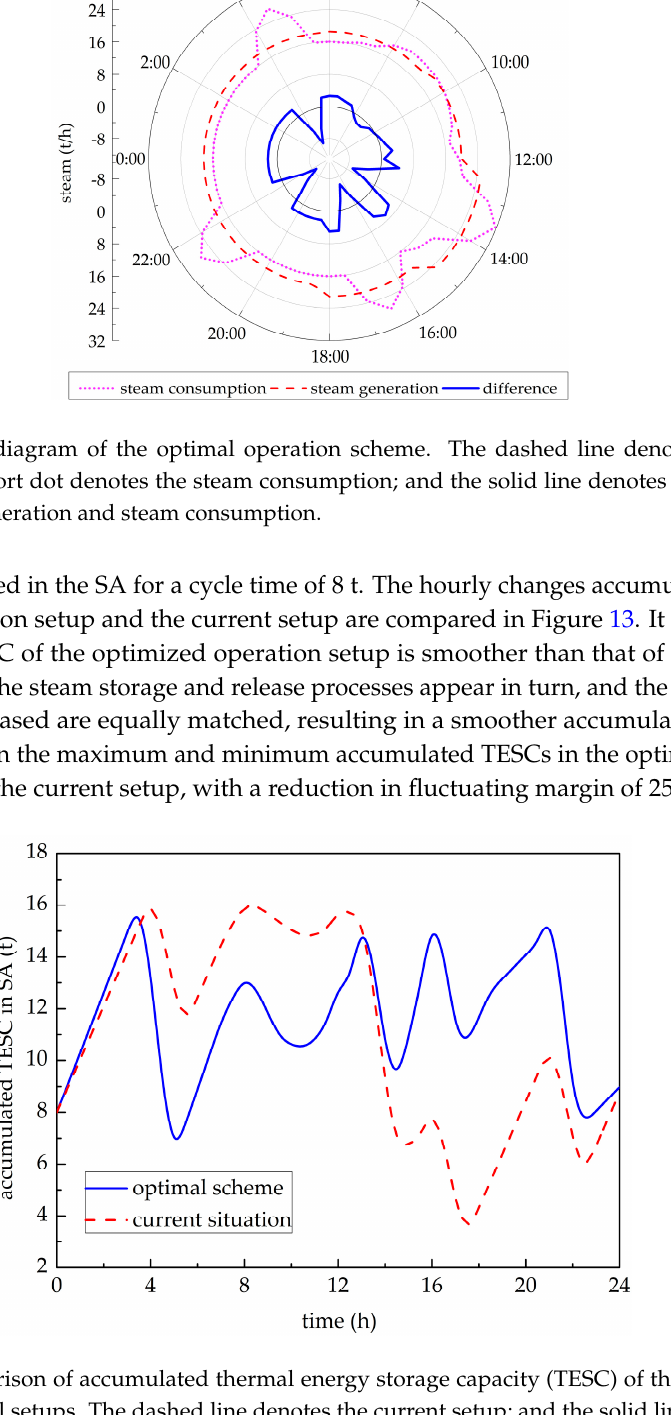
current operational setups. The dashed line denotes the current setup; and the solid line denotes the